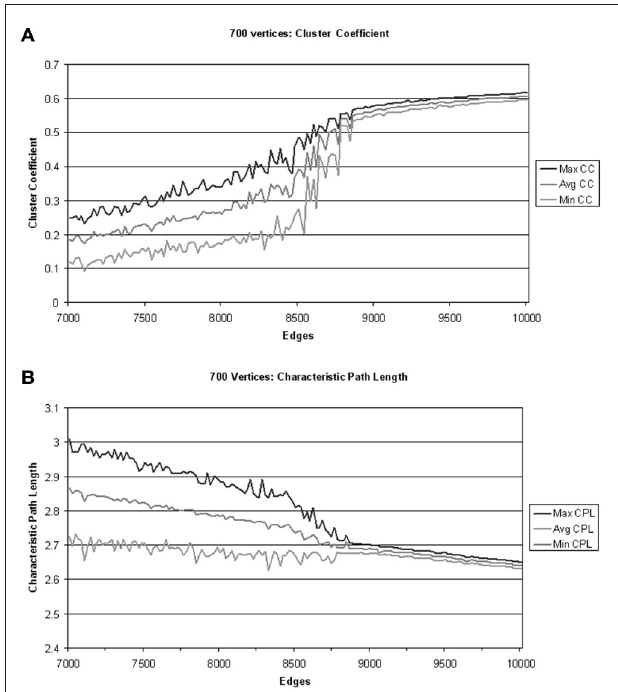
FIGURE 3 | Evolution under adaptive rewiring of maximum, minimum, and average cluster coefficient and characteristic path length. (A) The values of minimum, maximum and average CC for networks of 700 vertices and edges ranging from [7000 , 7020 , 7040 ,... , 10 , 000] after extensive adaptive rewiring. Note that beyond 9000 edges, CC-values tighten to a narrow range, indicating strong and consistent clustering behavior. (B) The values of minimum, maximum, and average CPL for networks of 700 vertices and edges ranging from [7000 , 7020 , 7040 ,... , 10 , 000] after extensive adaptive rewiring. Beyond 9000 edges, CPL-values also tighten to a narrow range of low values. Thus, for 700 vertices, at least 9000 edges are needed for adaptive rewiring to converge to small-world